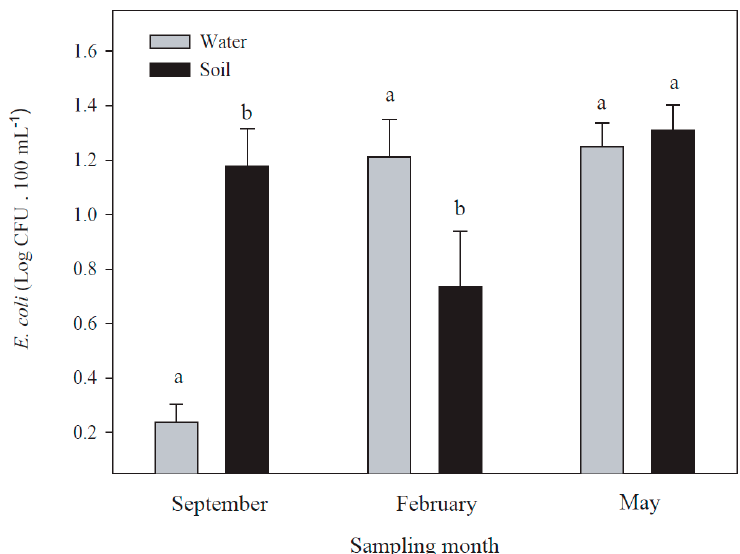
Figure 5. The presence of E. coli in reclaimed wastewater and soils in recreational parks during three seasons. Different letters indicate significant differences between conditions, using Student’s t ‐ test for independent samples at p < 0.05. Whisker lines represent the standard error.